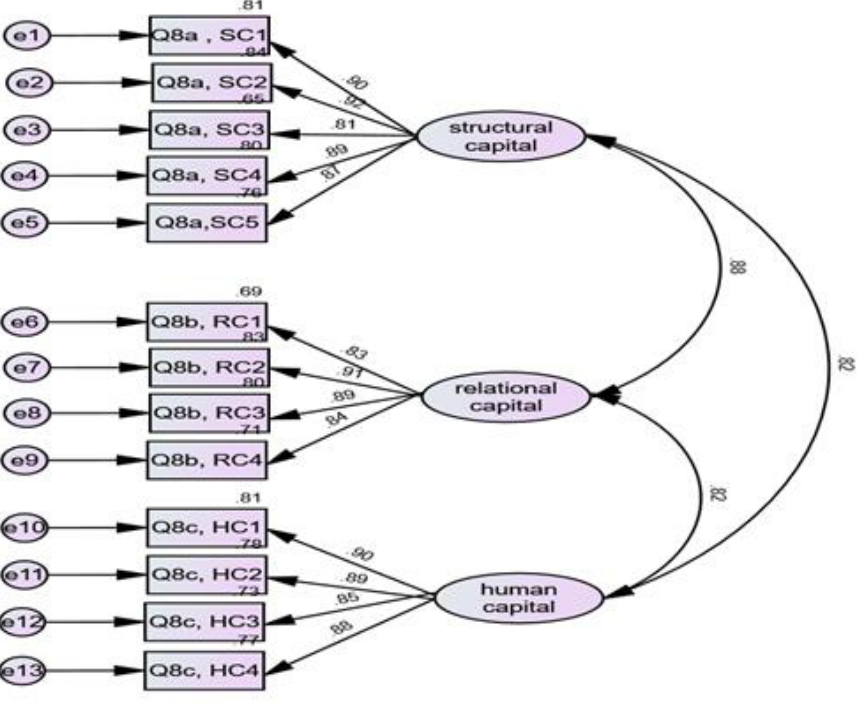
Fig. 2: Correlations for intellectual